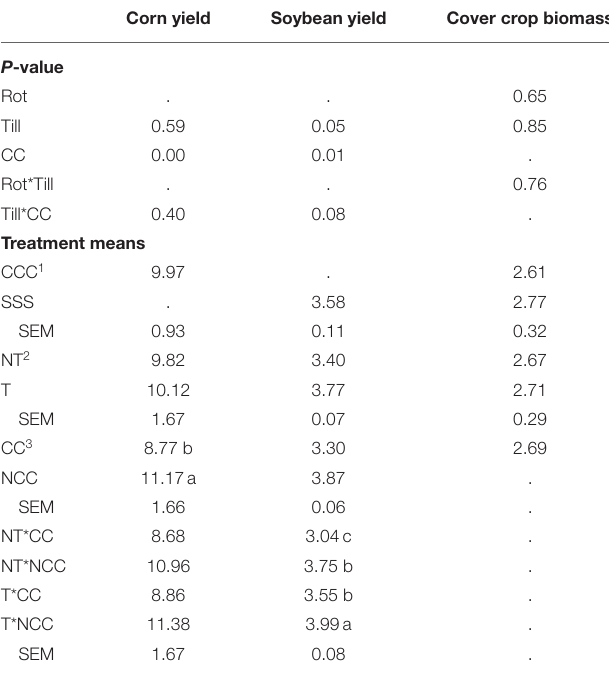
TABLE 3 | Analysis of variance (ANOVA) results for the main effects and interactions of crop rotation (Rot), tillage (Till), and cover crop (CC) on corn and soybean yields (Mg ha − 1 ) and cover crop biomass (Biomass, Mg ha − 1 ). Corn